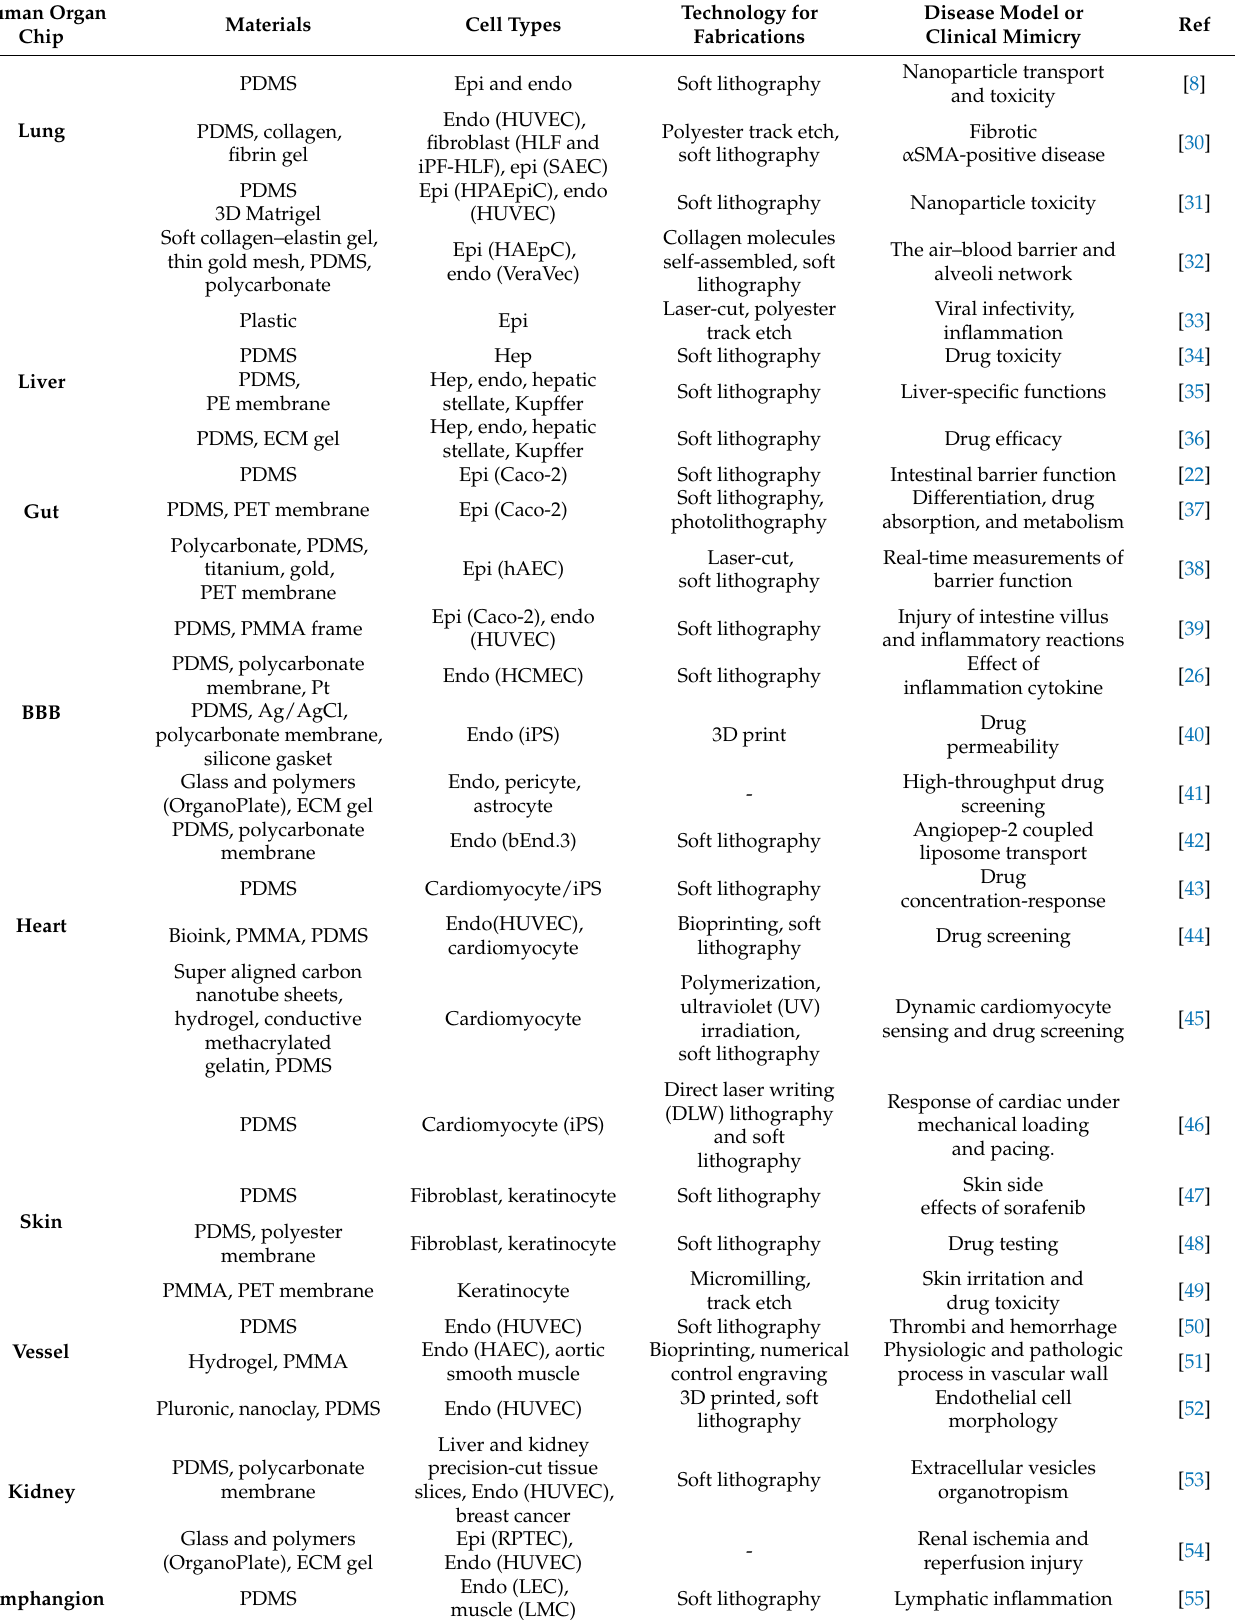
Table 1. Human disease and clinical responses replicated in single organ